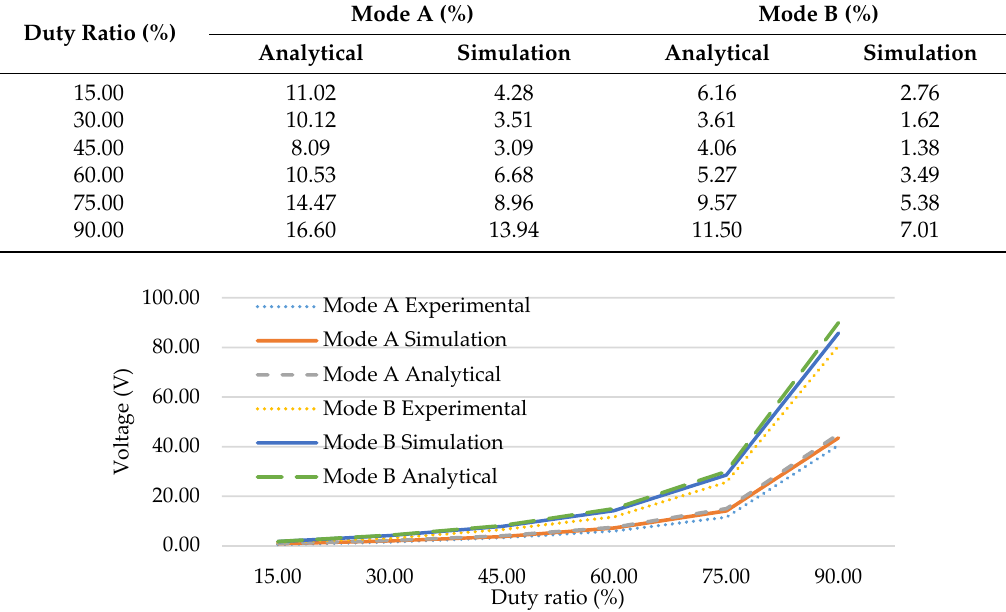
Figure 15. Validation of the converter output voltage for its operation in Mode A (having an input voltage of 5 V) and Mode B (having an input voltage of 10 V) against the simulation results and analytical calculations.